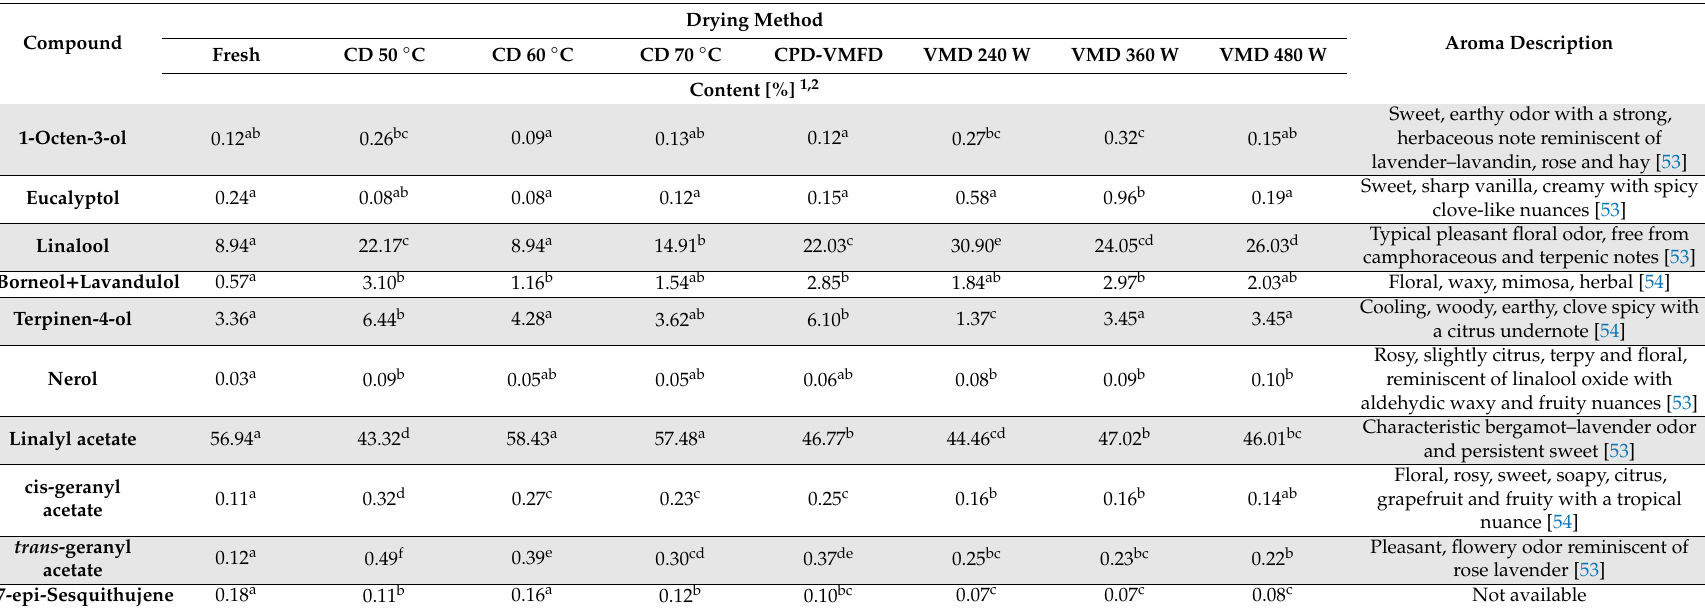
Table 5. Odour-active constituents of true lavender flowers and their variability regarding various drying